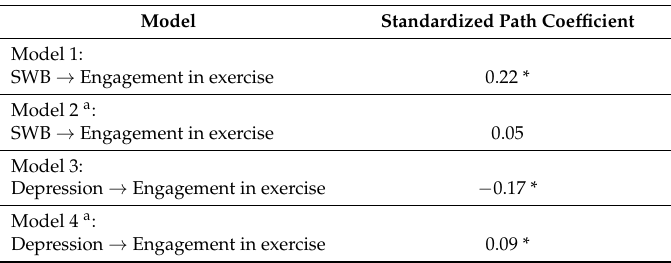
Table 4. Standardized Path Coefficients and p -values for Mediation Analyses within the Full Sample.